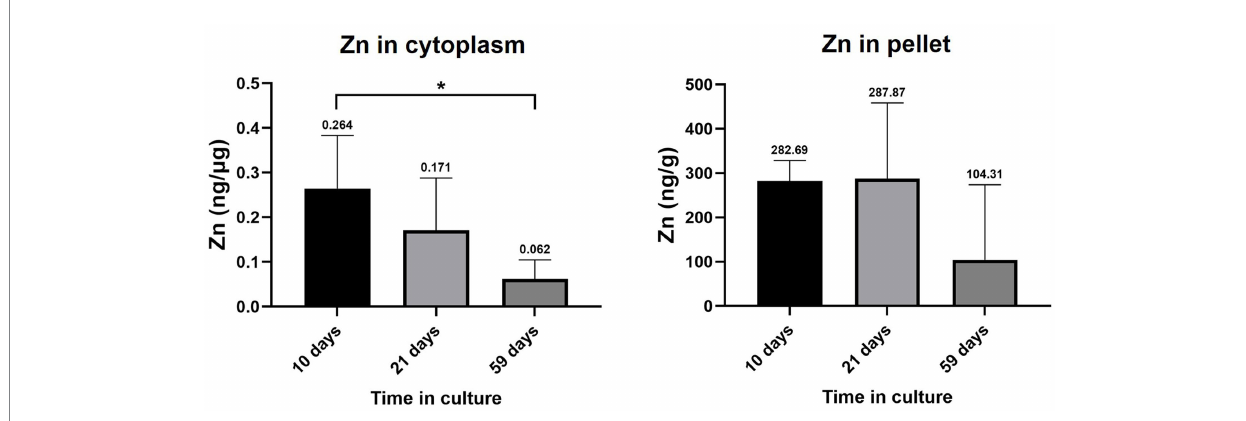
FIGURE 5 Zinc levels in the cytoplasm and pellet fraction of RPE cells at 10, 21, and 59 days in culture. Data is represented as concentration (ng Zn· μ g − 1 total protein in the cytoplasm; and ng Zn·g − 1 sample in the pellet) and error bars depict the standard deviation. *: significant p- value of two-way ANOVA (<